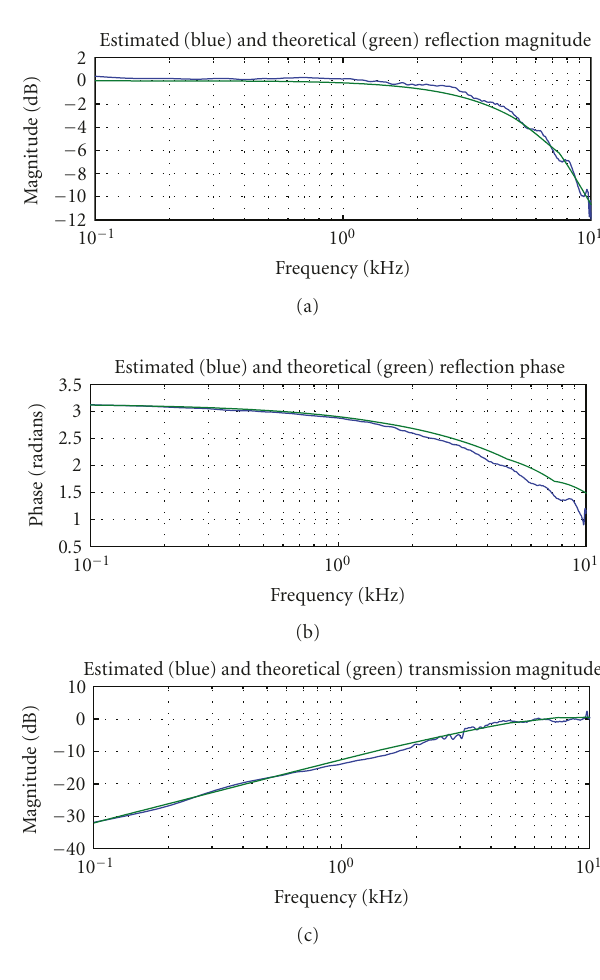
Figure 8: Estimated (blue) and theoretical (green, smooth curve) open-end cylinder reflection magnitude (a) and phase (b). Theory is based on the Levine and Schwinger approximation [33] with suitable expressions found in [12]. The estimated transmission magnitude (blue) is plotted with the amplitude complement (this assumption is valid for cylinders only) of the theoretical (green, smooth curve) reflection